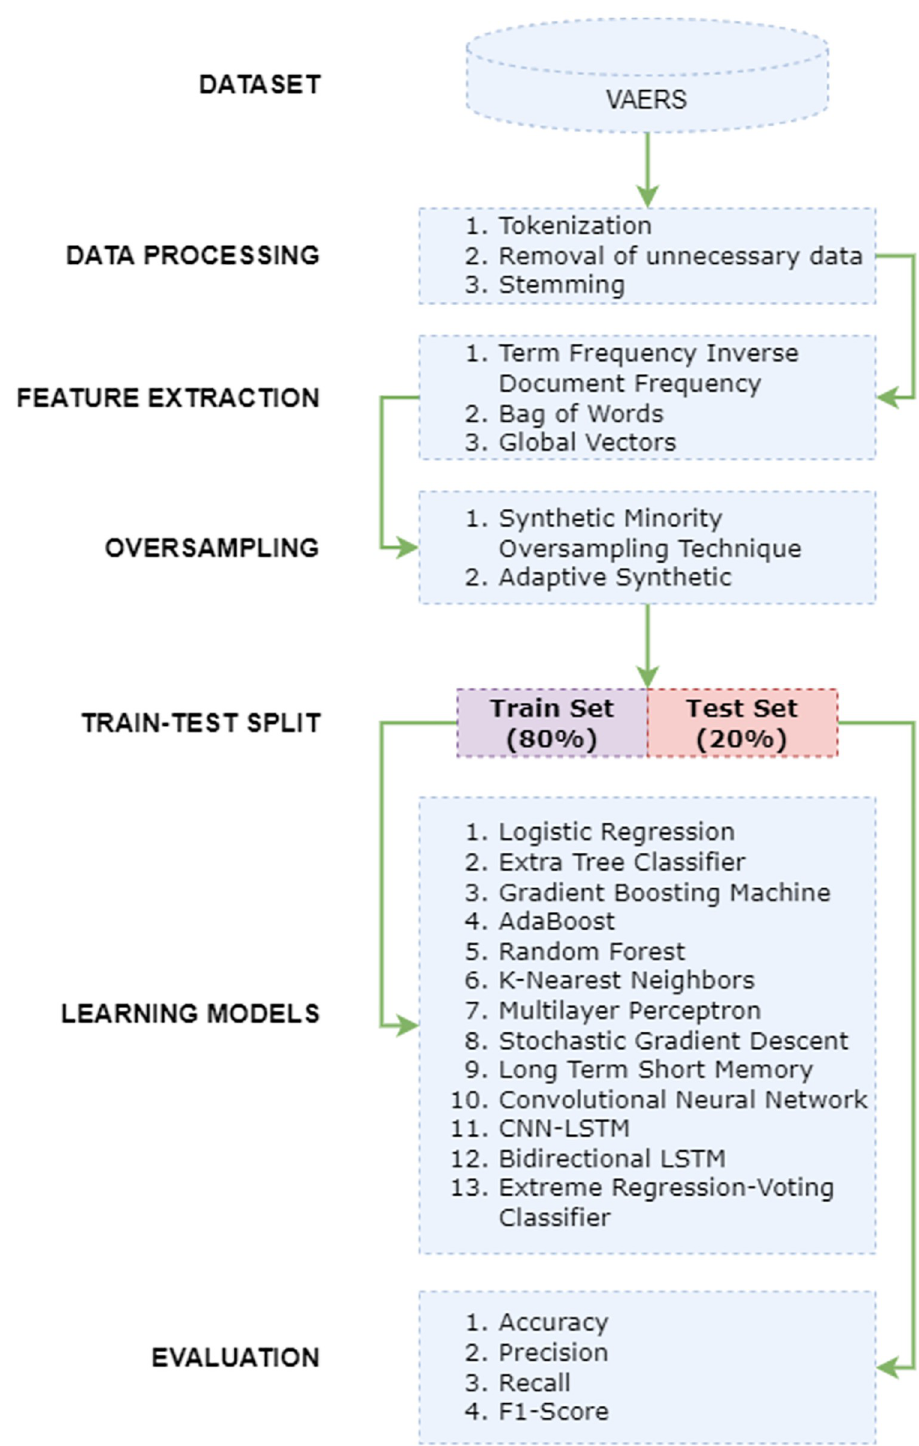
Fig 3. Architecture of the methodology devised for prognosis of death risks.